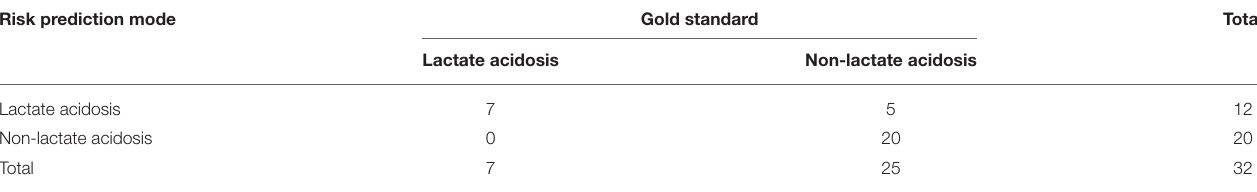
TABLE 5 | Thirty-two patients older than 85 years verified the stability of the risk prediction